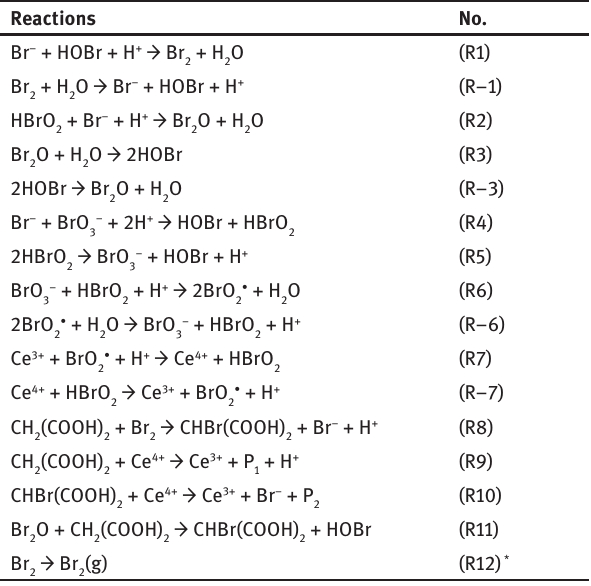
Table 1: A model of the Belousov−Zhabotinsky reaction [14].